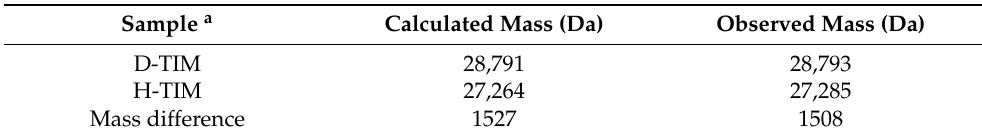
Table 4. Intact mass MS analysis of proteins isolated from cells grown in DD-M9 (in situ perdeuterated pyruvic acid).